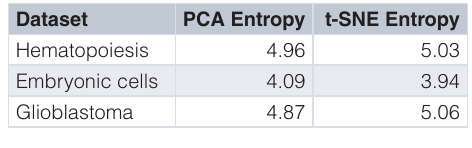
Table 2. Entropy in 2D lower dimension